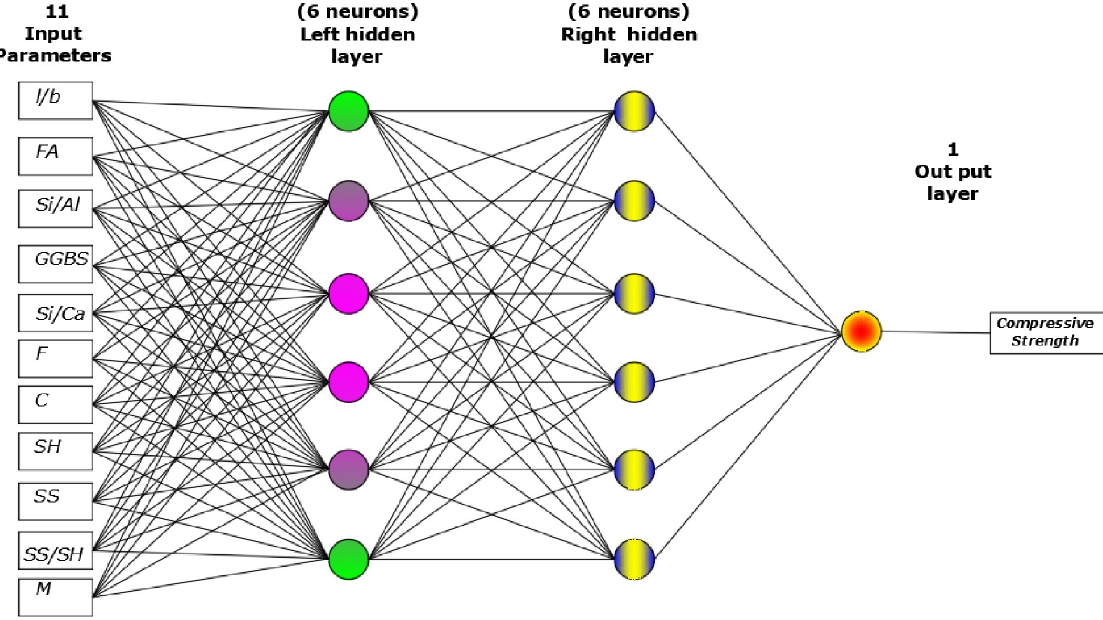
Fig 17. Optimal network structures of the ANN Model.